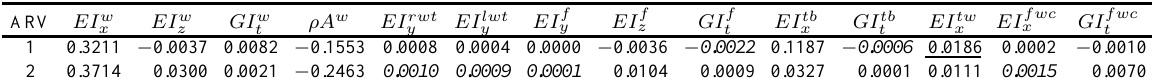
Table 4 Sensitivity matrix of virtual antiresonances to model properties